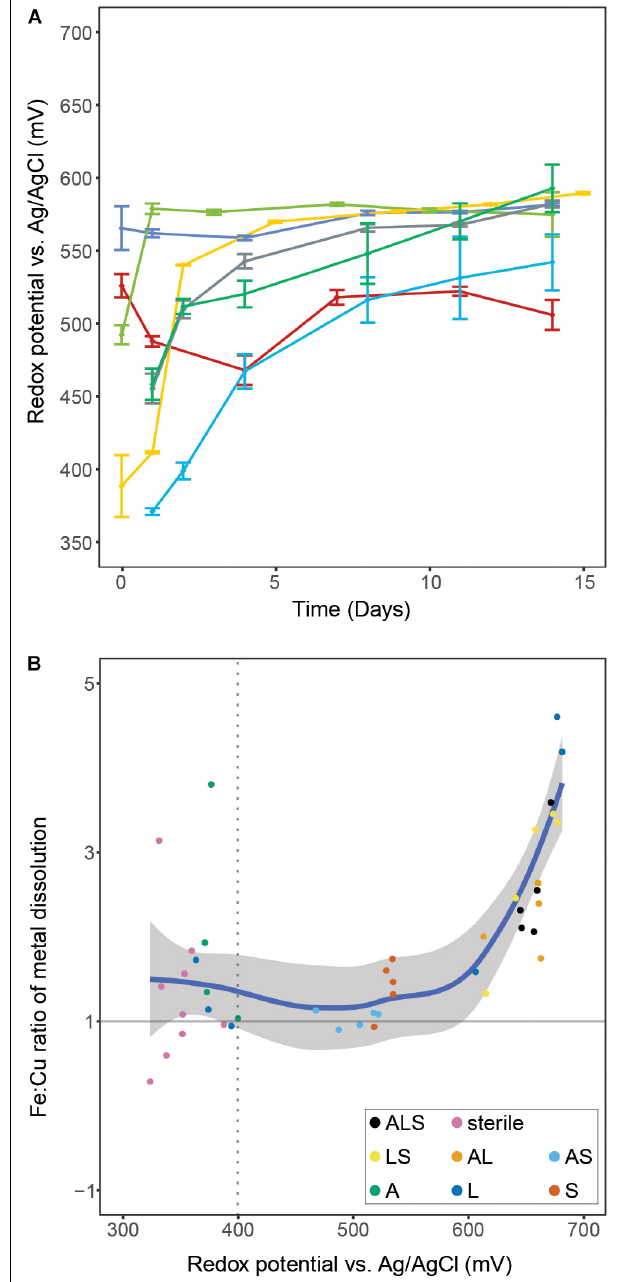
FIGURE 2 | Panel A shows redox potentials remaining below 600 mV during seven independent experiments containing only S. thermosulfidooxidans for microbial iron oxidation. Data points represent means ± SD ( n = 4). Panel B illustrates the correlation of the ratio of released iron:copper vs. redox potential during bioleaching of chalcopyrite concentrate with various combinations of the three model species. The ratio was calculated by dividing the amounts of the two metals that were released between two consecutive sampling points during the leaching experiments. The regression was calculated using the LOESS method with 95% confidence interval marked by the shaded area. The dotted line denotes the onset of microbial iron oxidation indicated by a redox potential above 400 mV. Abbreviations in the legend denote: A, A. caldus ; L, L. ferriphilum ; and S, S. thermosulfidooxidans